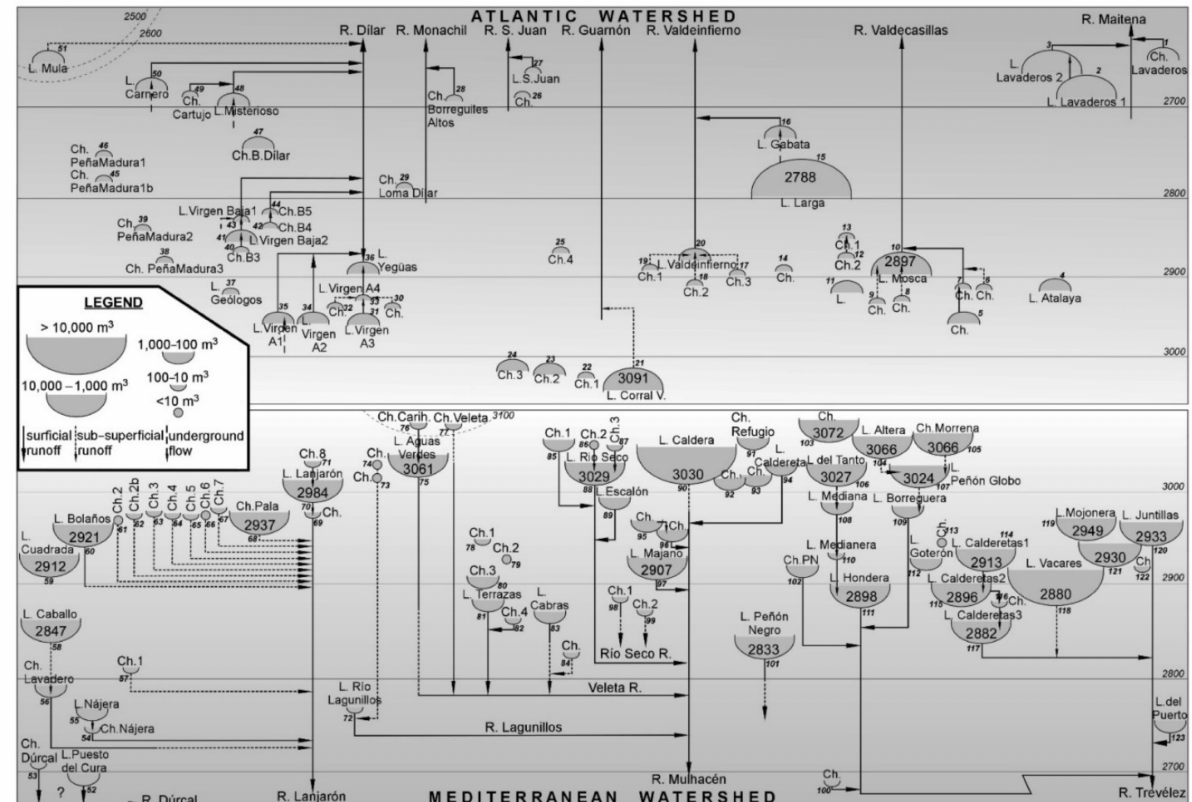
Figure 7. Positional relationship between the water-bodies of Sierra Nevada, ordered by watersheds and headwaters: the streams draining them as surficial/sub—surficial runoff are indicated. The larger numbers included in the larger bodies are their heights (m asl). Potential underground flows in the water-bodies (springs) and infiltrations occurring in the outflows are also shown. The water-body of Laguna Seca is not included because it is the lowest water-body (<2400 m asl). The small numbers near each water-body indicate the